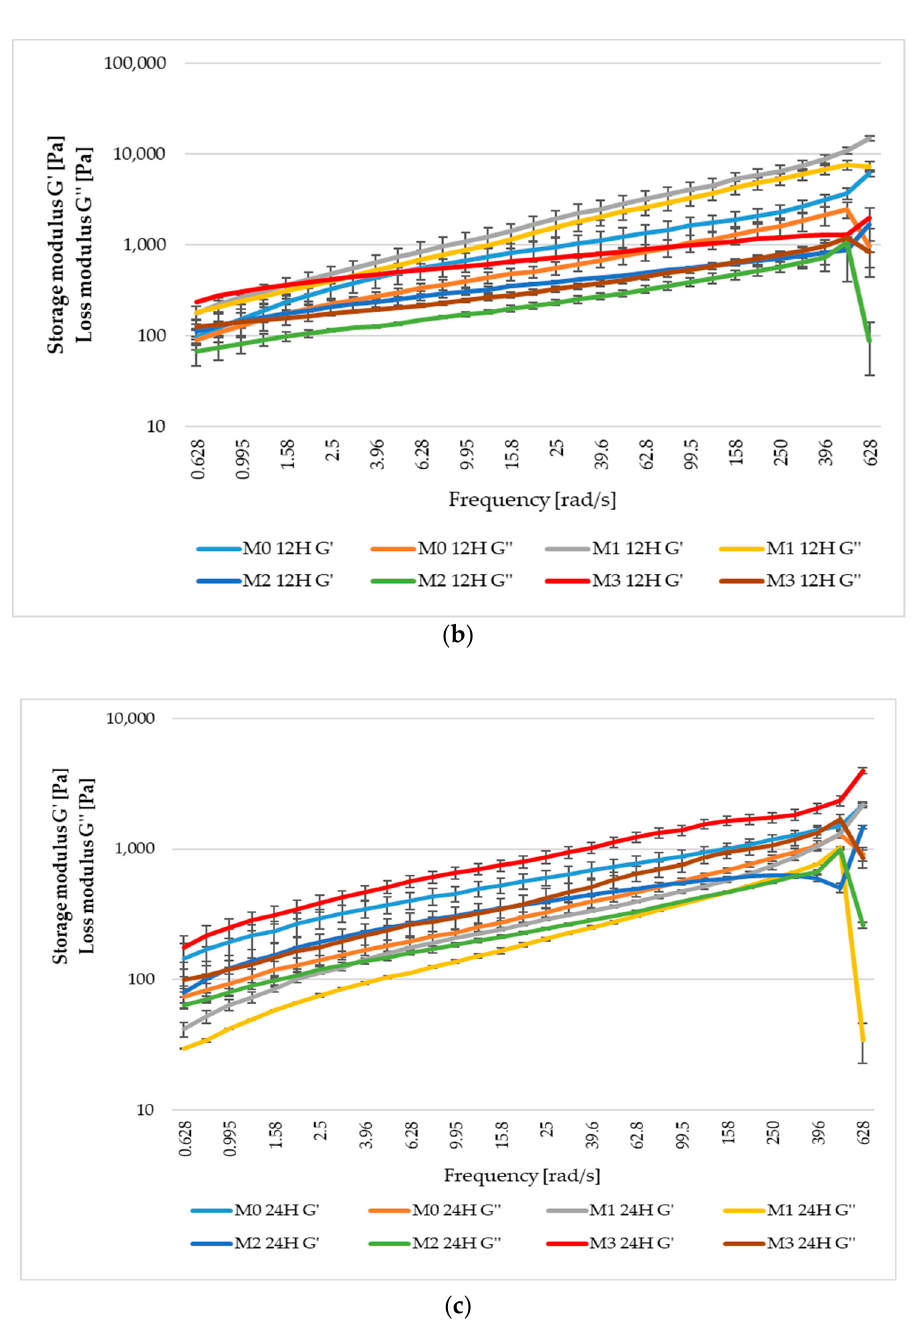
Figure 4. The storage (G’) and loss (G’’) modulus for sourdough fermented for 0 ( a ), 12 ( b ), and 24 ( c ) hours with Lactiplantibacillus plantarum ATCC 8014.